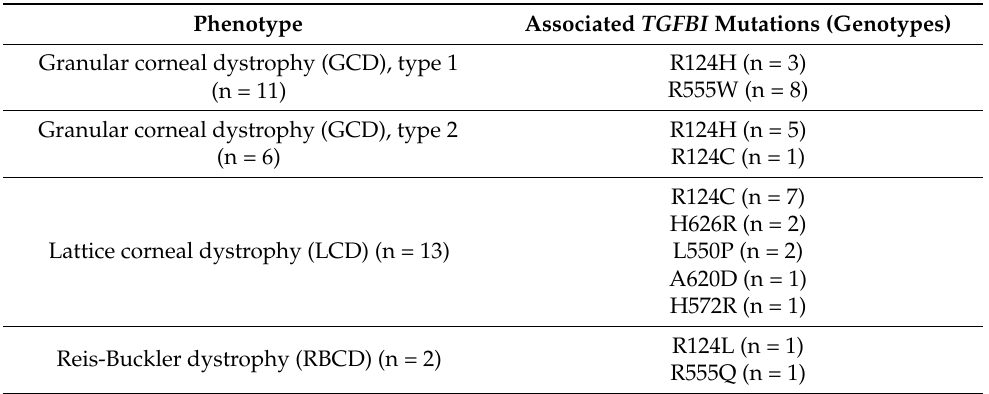
Table 2. The distribution of genotypes of TGFBI mutations in each phenotype of TGFBI corneal dystrophy.